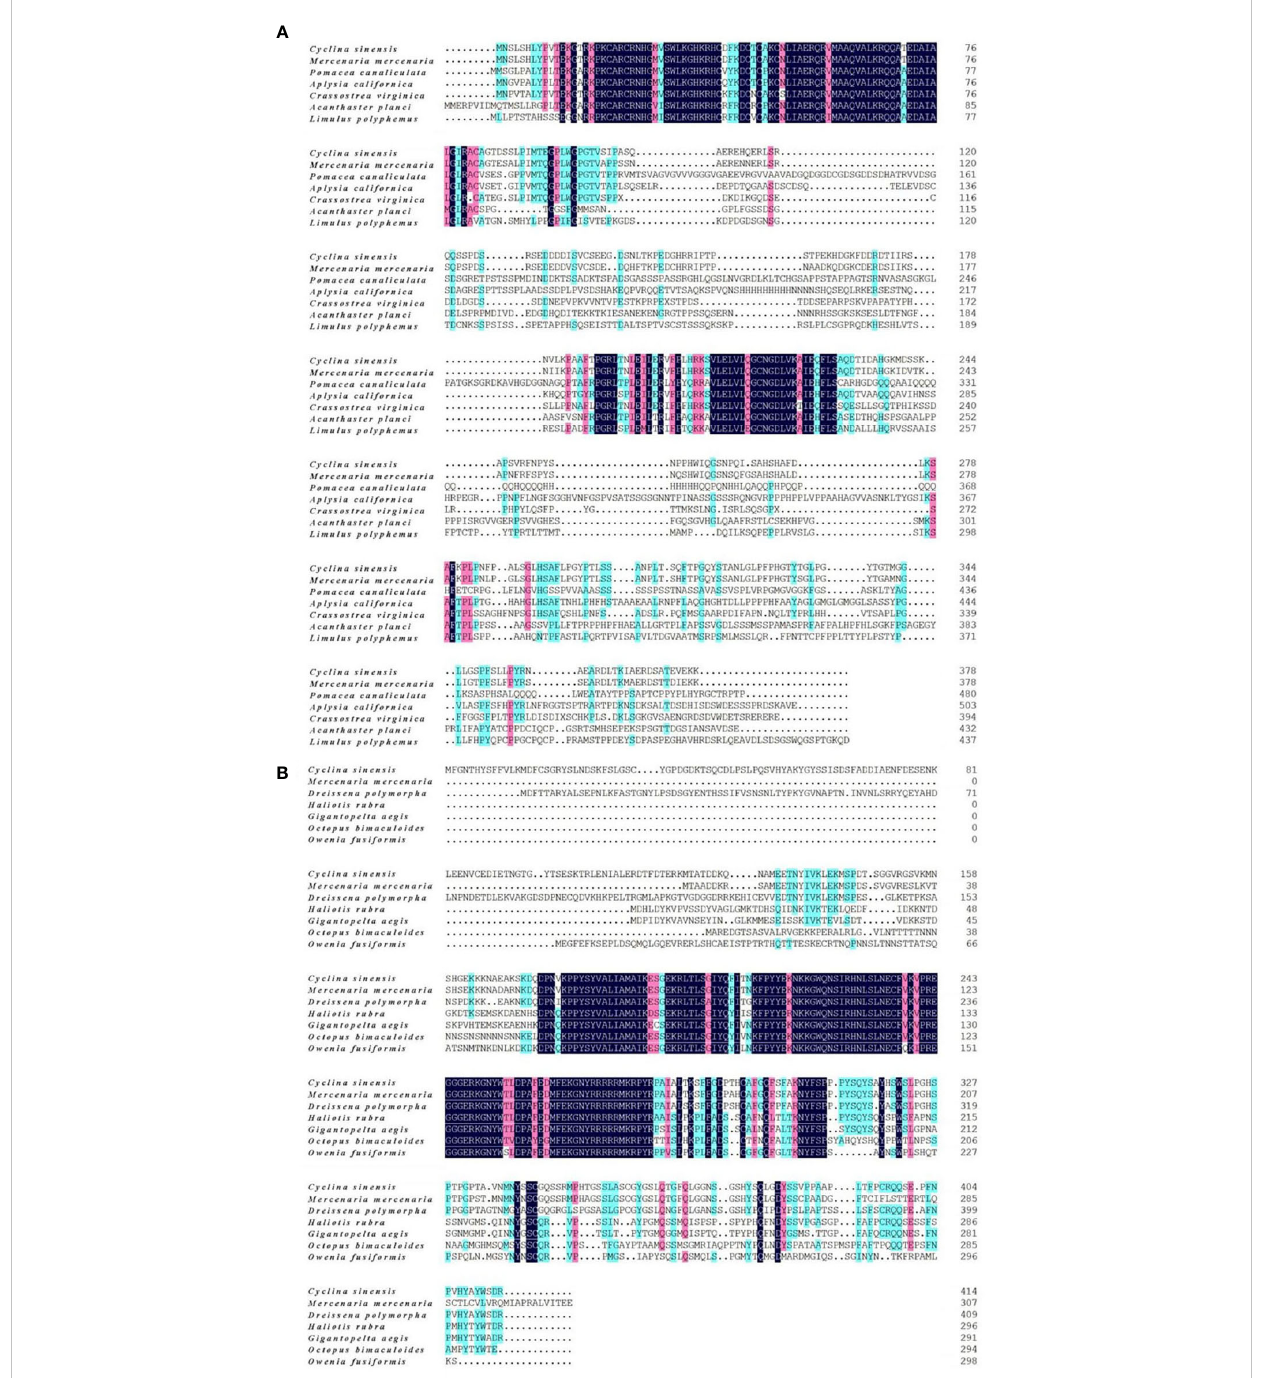
FIGURE 3 The amino acid alignment of DMRT3 (A) and FOXL2 (B) from C. sinensis and other species. Different colors represent residues sharing homology, cyan, pink and black regions indicate homology above 50%, above 75%, and equal to 100%,